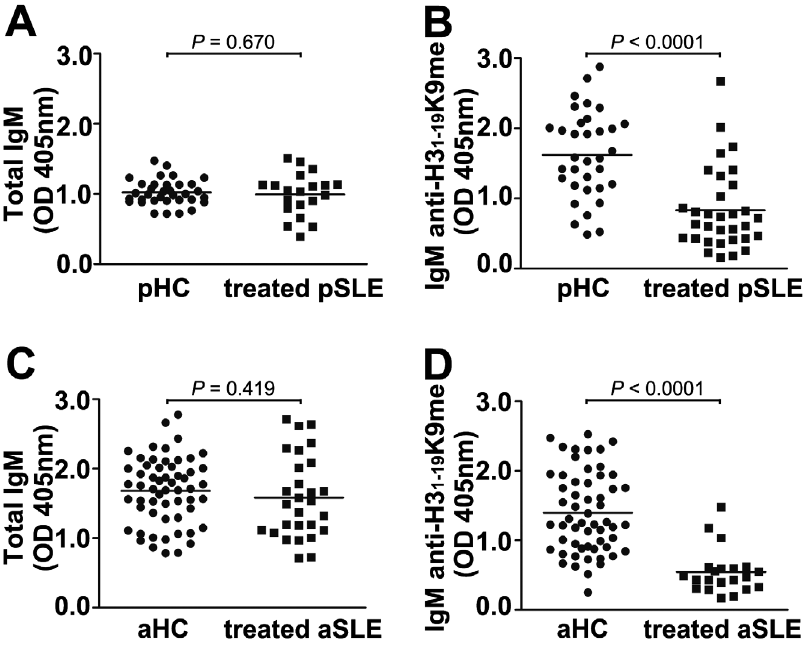
Figure 11. Effect of medical treatments on total IgM and IgM anti-H3 1 – 19 K9me. (A) and (C) Total IgM of pediatric and adult samples. (B) and (D) IgM anti-H3 1–19 K9me of pediatric and adult samples. P values between the healthy controls and treated SLE were calculated using the Student’s t test. The horizontal bars indicate the mean values in each group. The results are representative of two independent experiments.